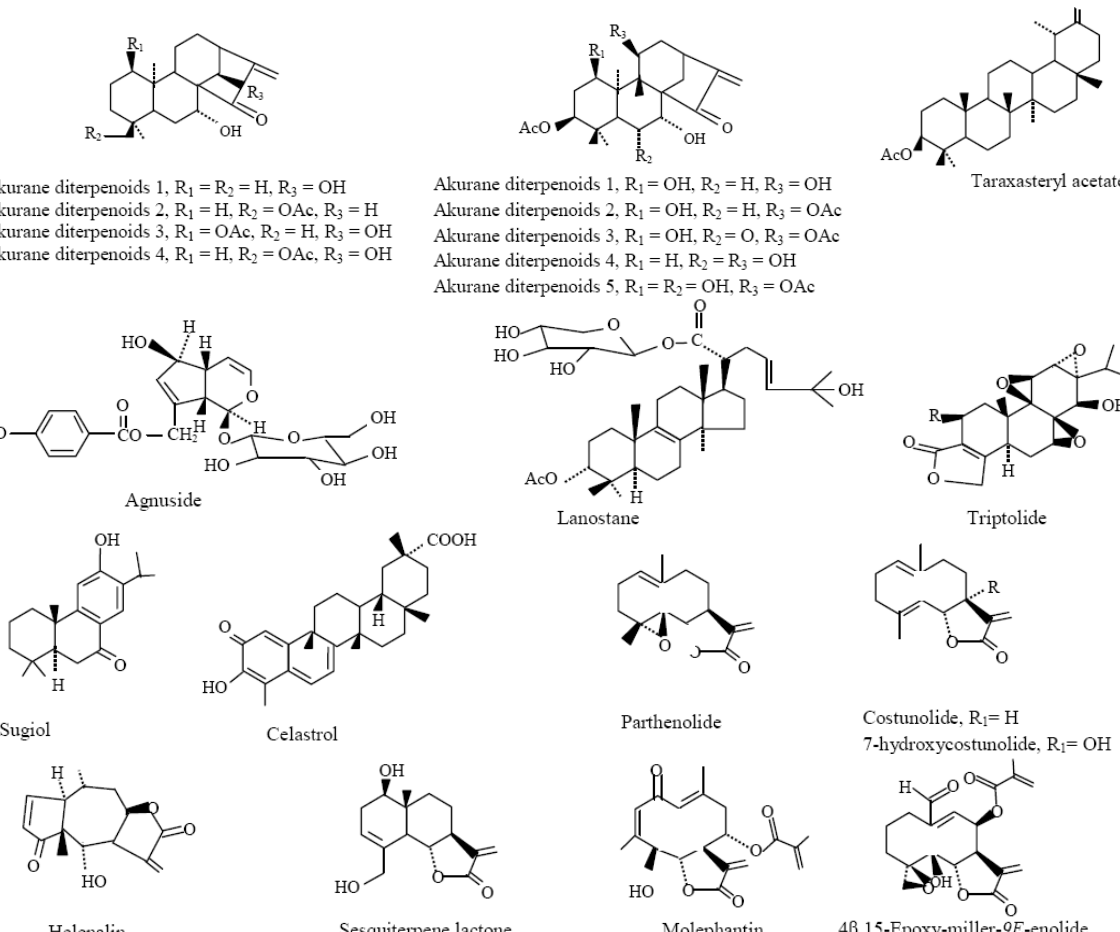
Figure 4. Chemical structures of terpenoids. Adapted from Gautam and Jachak